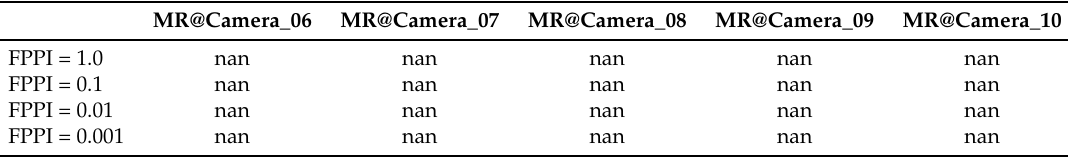
Table 8. Accuracy table @ Cameras_06–10,